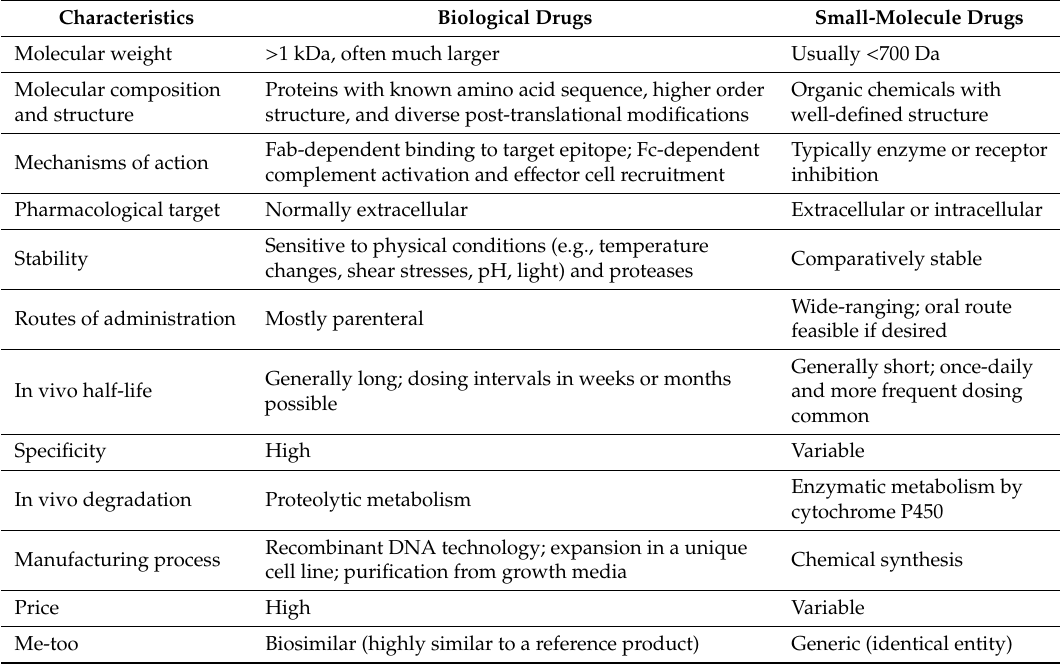
Table 2. Comparison of the key characteristics of biological and small-molecule